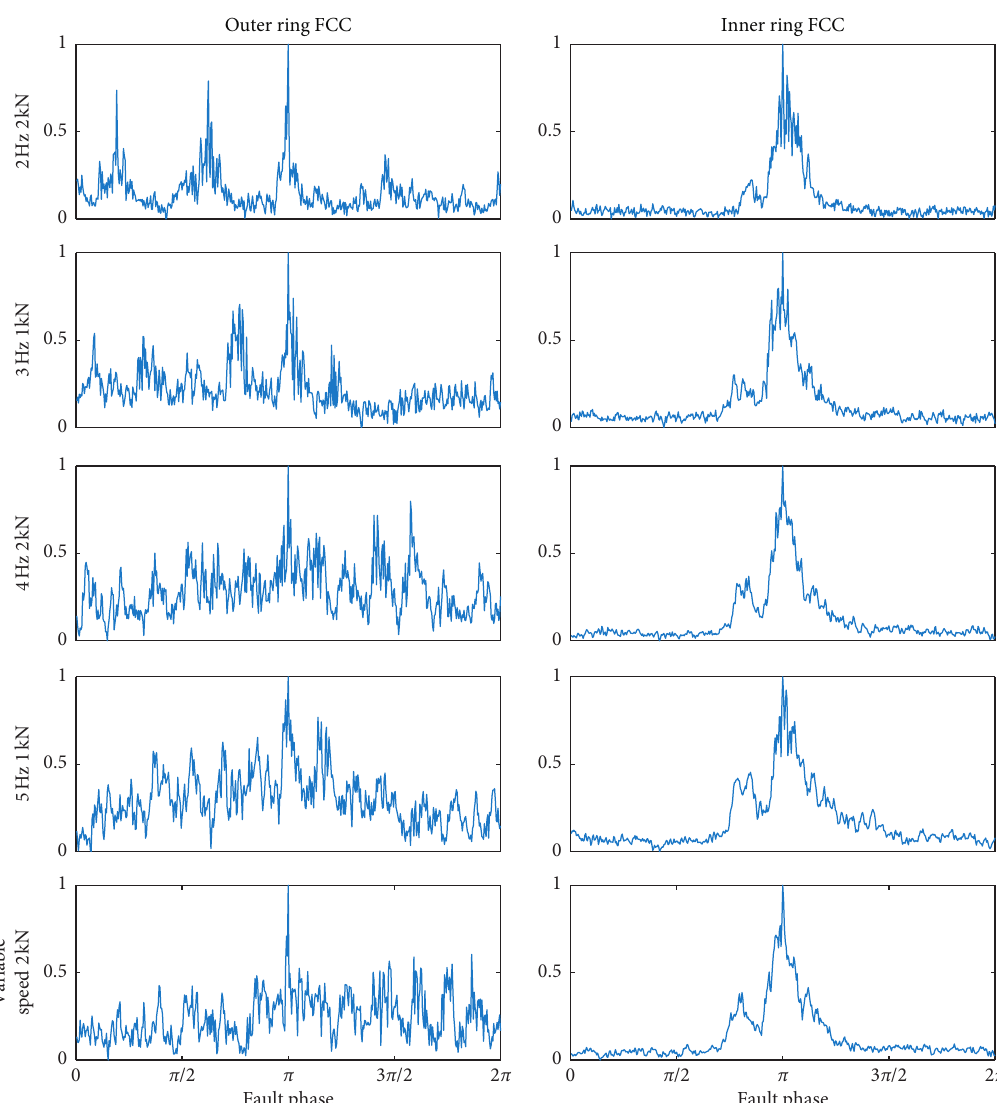
Figure 14: Feature extraction results of 1.1mm inner ring fault under different working conditions.